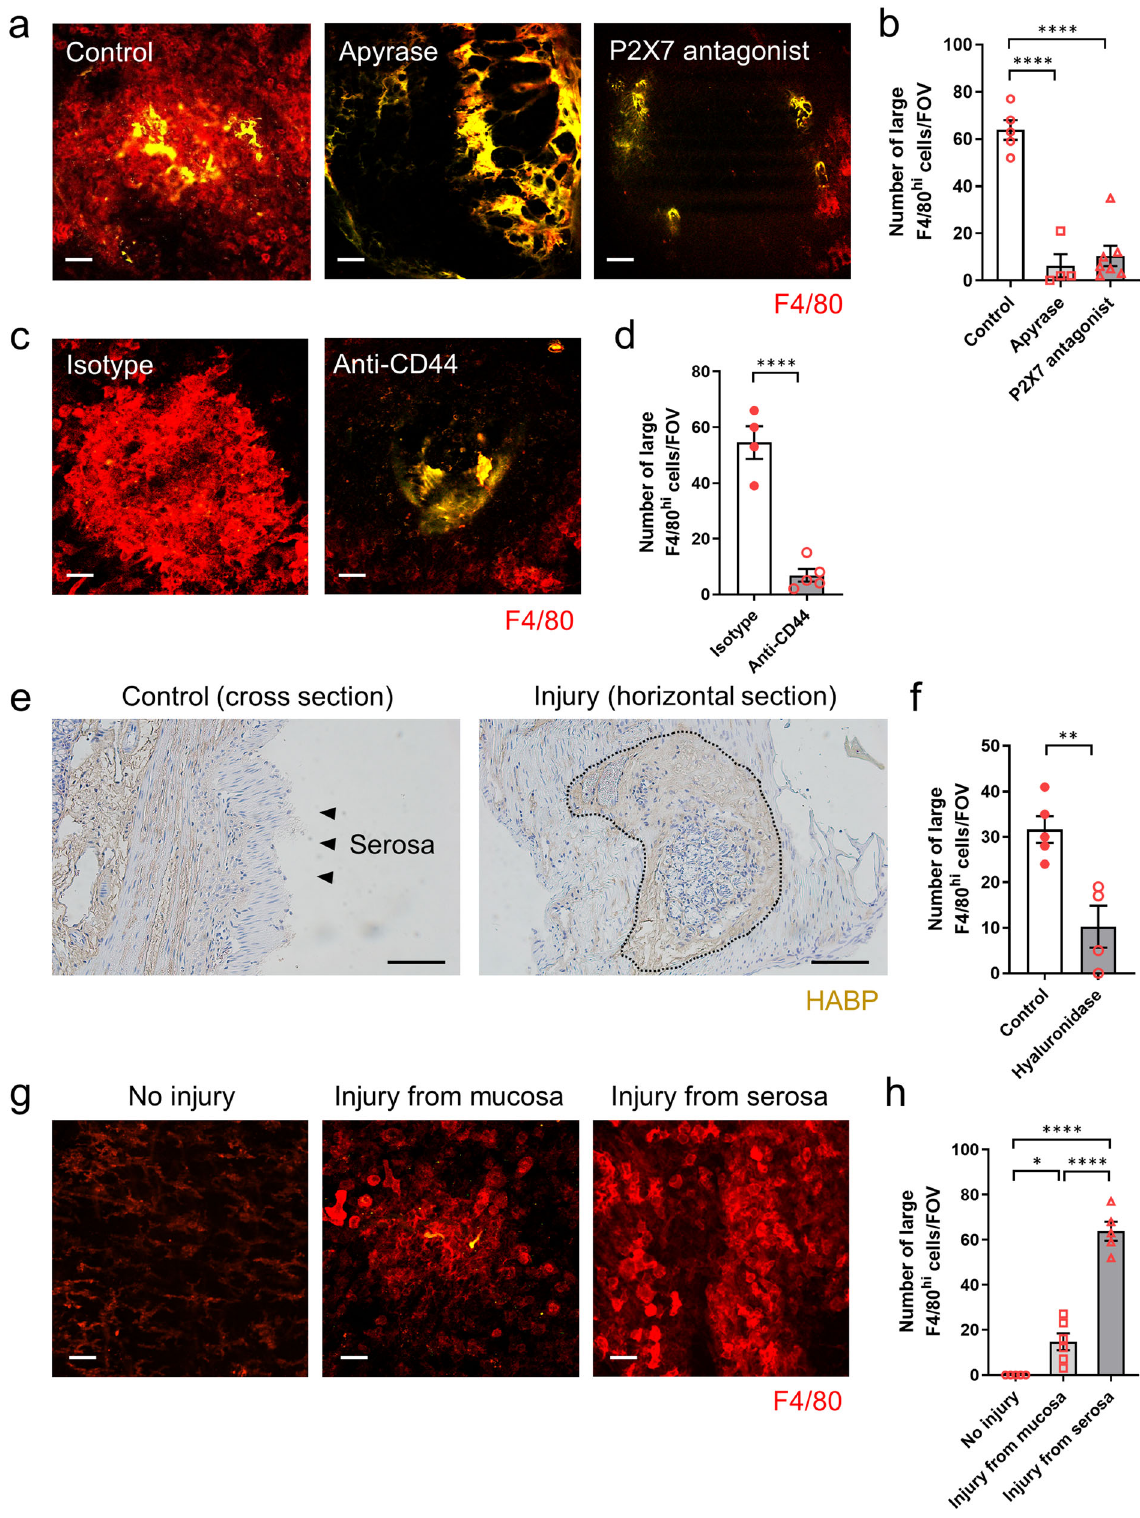
model (Fig. 6c – e). We also subjected Cx3cr1 GFP/ + Ccr2 RFP/ + mice to DSS-induced colitis and found that no CCR2 + and/or CX3CR1 + signal co-localized with the large F4/80 hi cells (Fig. 6f) indicating that these are distinct cell lineages. These fi ndings indicate that these large invading macrophages are derived from the peritoneum, not the vasculature. For that matter, immuno- fl uorescence staining showed increased expression of hyaluronan